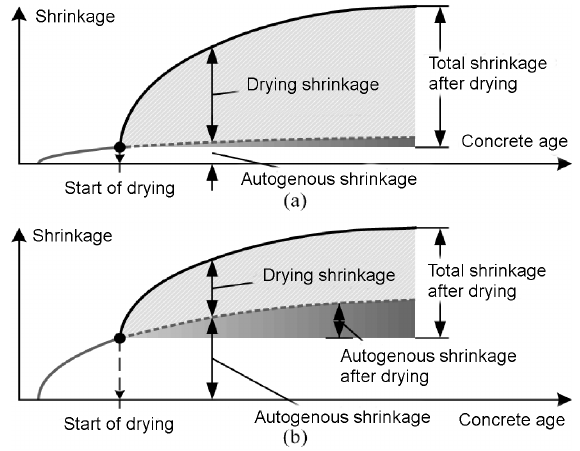
Fig. 1. Shrinkage strain components in normal (a) and high-strength (b) concrete (Sakata & Shimomura